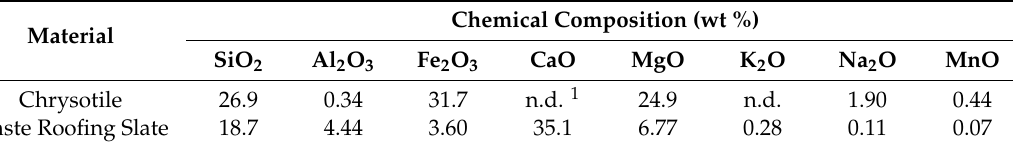
Table 1. Chemical composition of chrysotile and waste roofing slate.